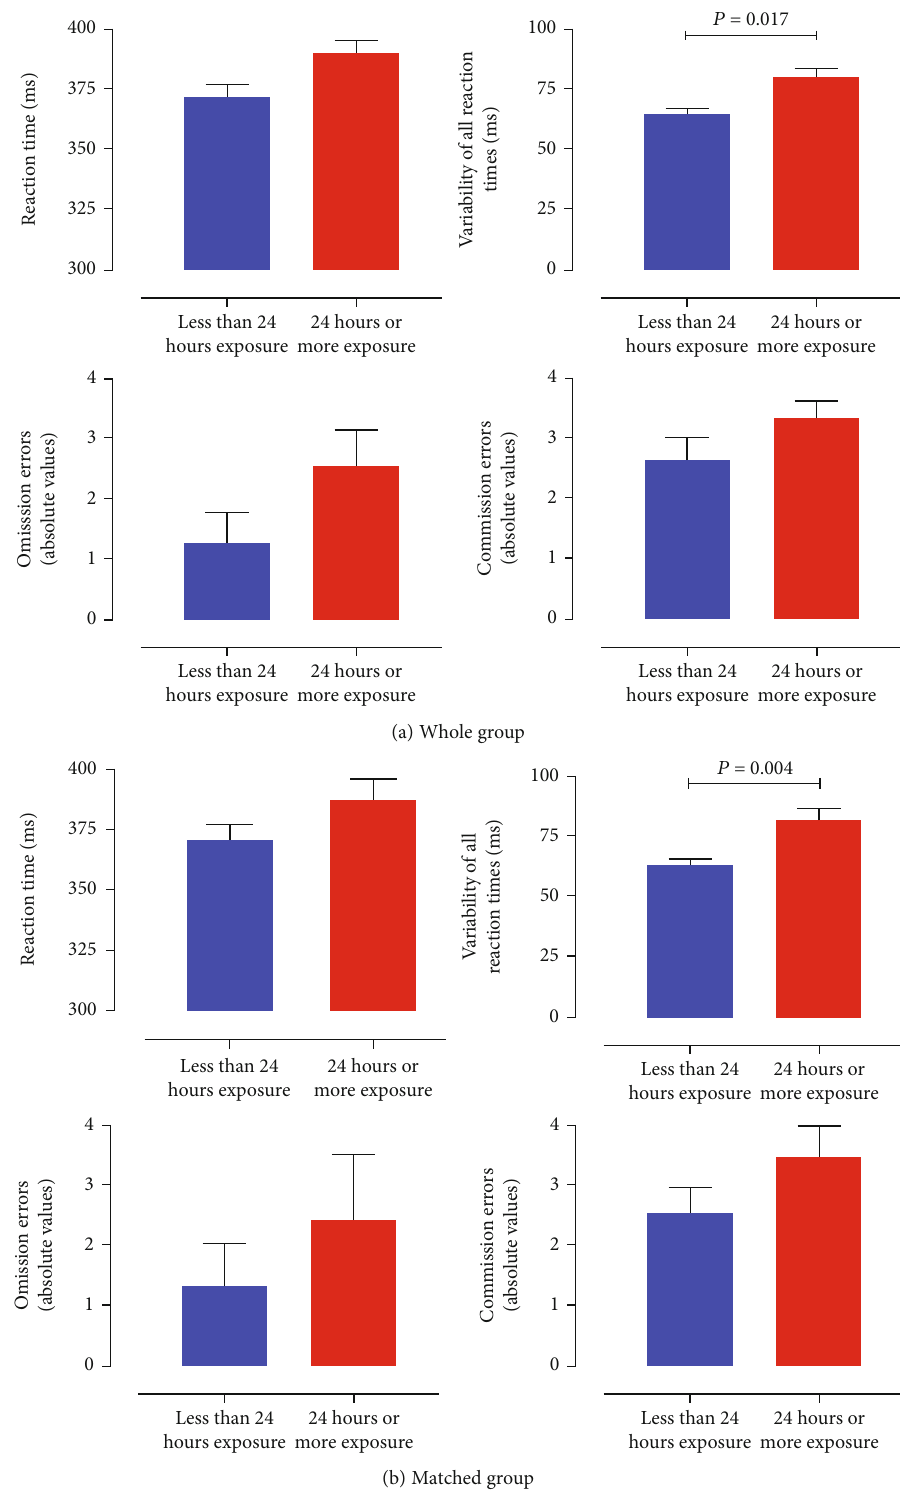
Figure 2: (a) Bar graphs of the mean reaction time of the correct responses, mean variability of all reaction times of the correct responses, and mean omission and commission errors with standard error of the mean of the analysis with all participants included. (b) Bar graphs of the mean reaction time of the correct responses, mean variability of all reaction times of the correct responses, and mean omission and commission errors with standard error of the mean of the analysis of both groups matched for size. Blue bars depict participants with minimal COVID-19 exposure, and red bars represent those with substantial exposure to COVID-19